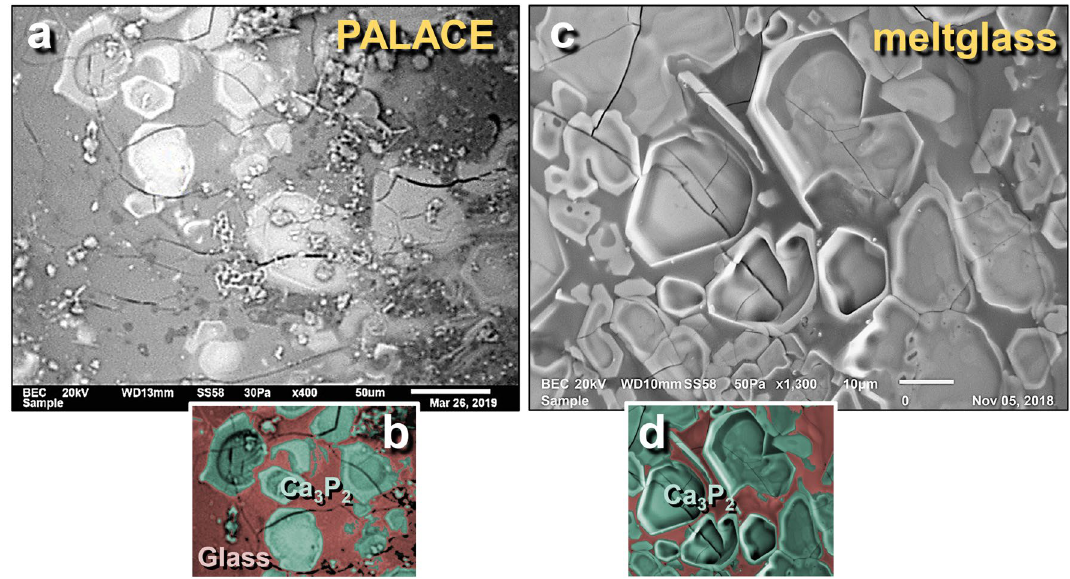
Figure 42. SEM images of calcium phosphide crystals in vesicles of mudbrick meltglass from the palace. ( a ) and ( c ) Crystals of calcium phosphide, Ca 3 P 2 , lining the inside wall of meltglass vesicles; ( b ) and ( d ) manually constructed EDS-based phase map of Ca 3 P 2 (green) crystals embedded in typical Ca–Al–Si melted